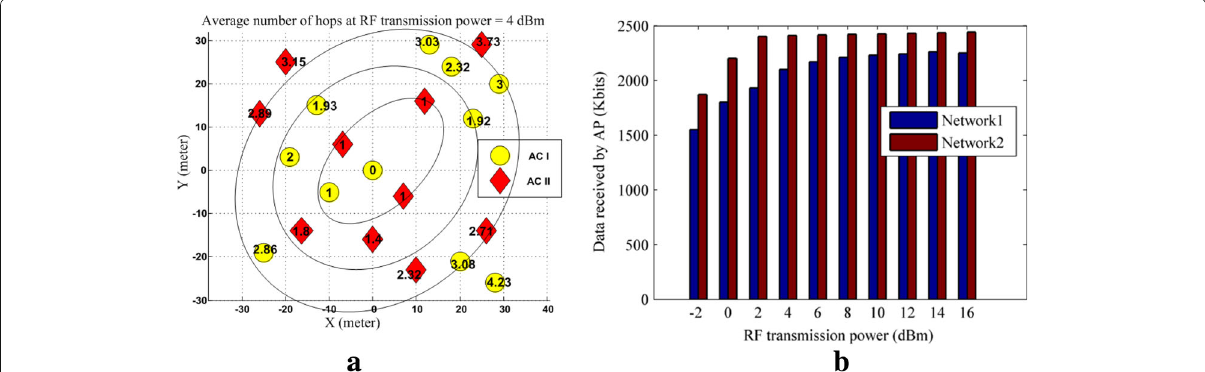
Fig. 11 Number of hops and throughput for simulation time of 2 s. a Average number of hops needed by user nodes. b Throughput at the